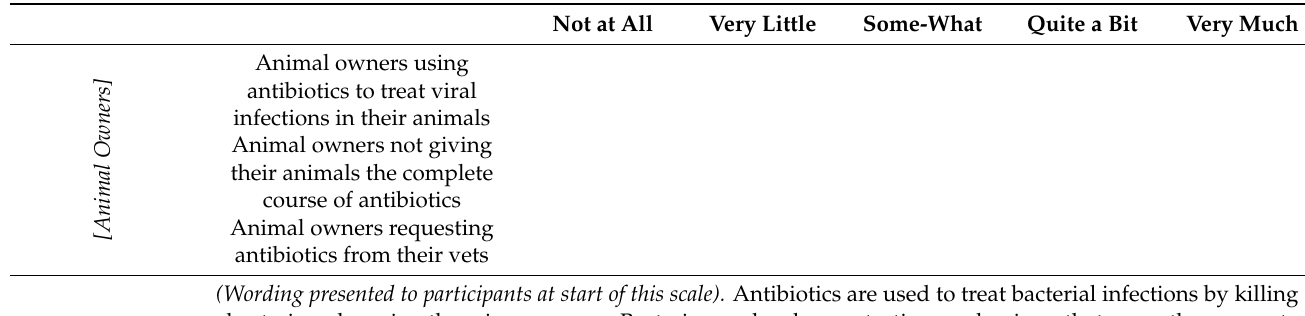
Table A3. Cont. Not at All Some-What Quite a Bit